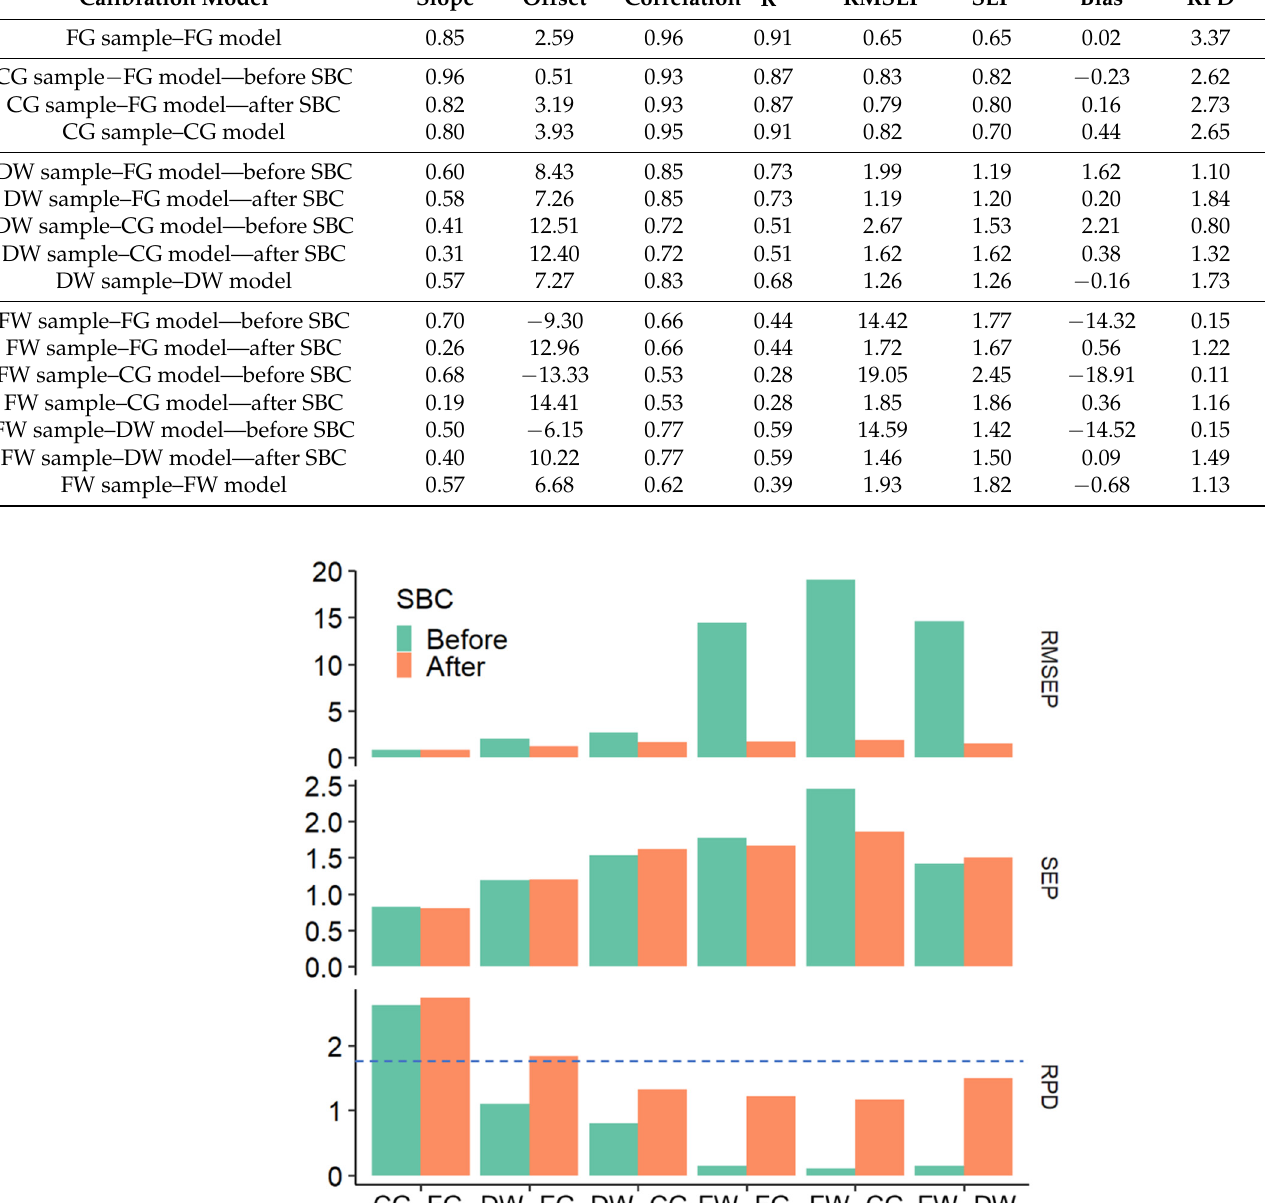
Table 3. Prediction results of the PLSR models for crude protein transferred across processing modes before and after the slope and bias correction (SBC) were applied to Database 2. The calibration model from the Master mode (Fine–Ground) was applied to each of the three satellite modes. The calibration model from the Coarse–Ground mode was applied to the Dry–Whole and Fresh–Whole modes, and the calibration from the Dry–Whole mode was applied to the Fresh–Whole mode. Calibration Model